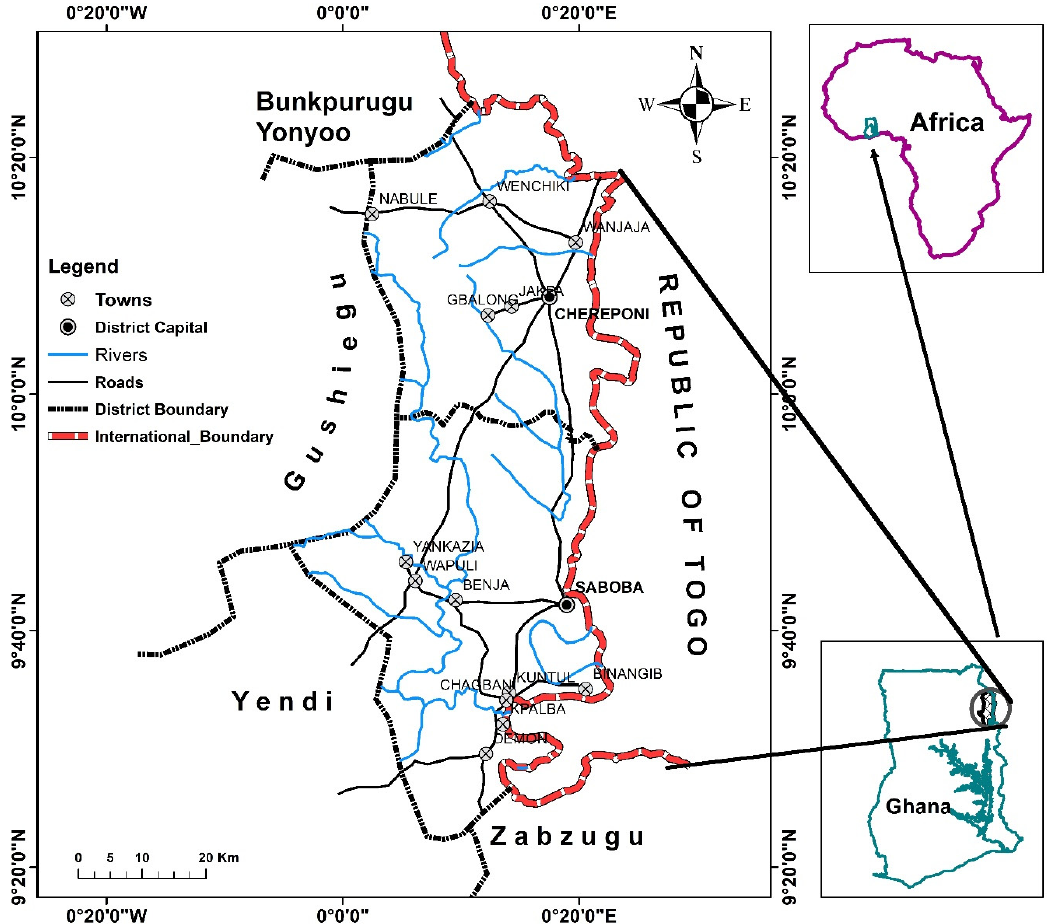
Figure 1. Location map of the study area.